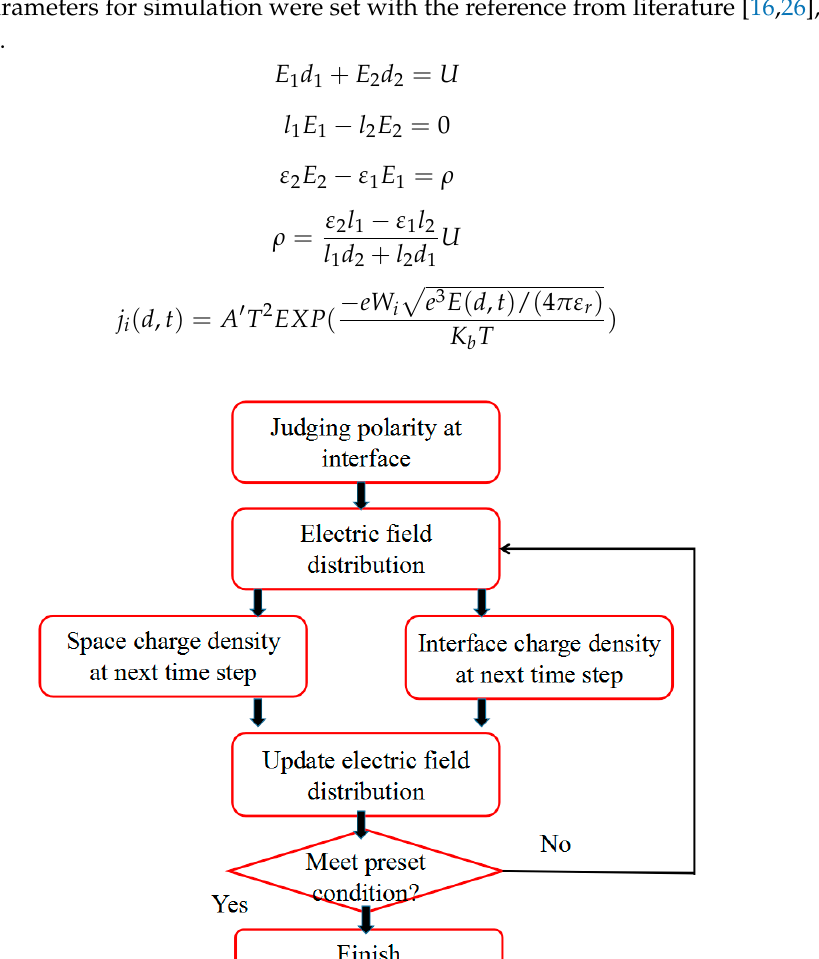
Figure 1. Diagram for Maxwell–Wagner polarization.